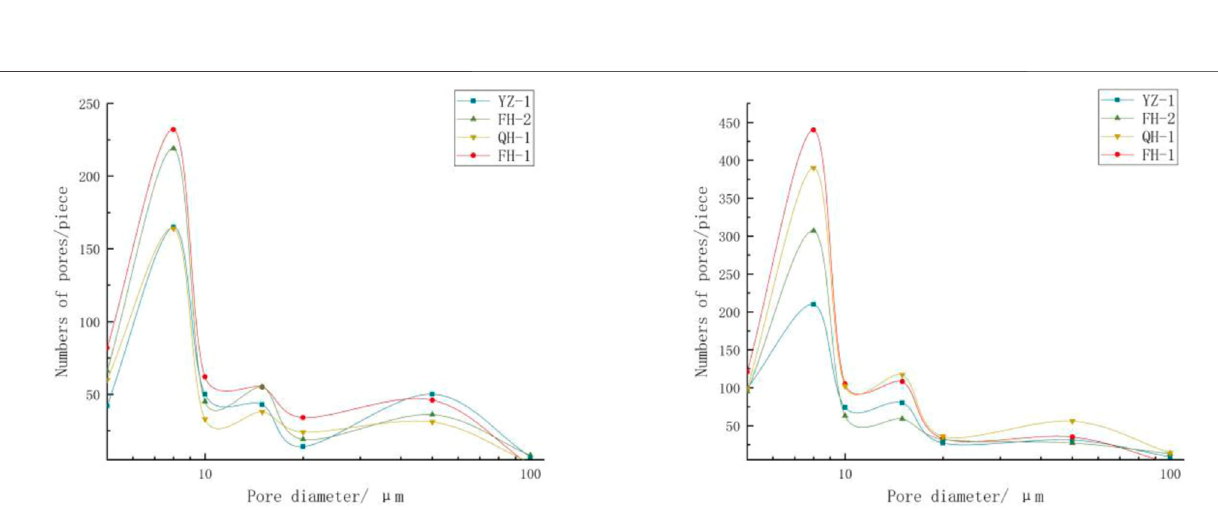
Frontiers in Earth Science |